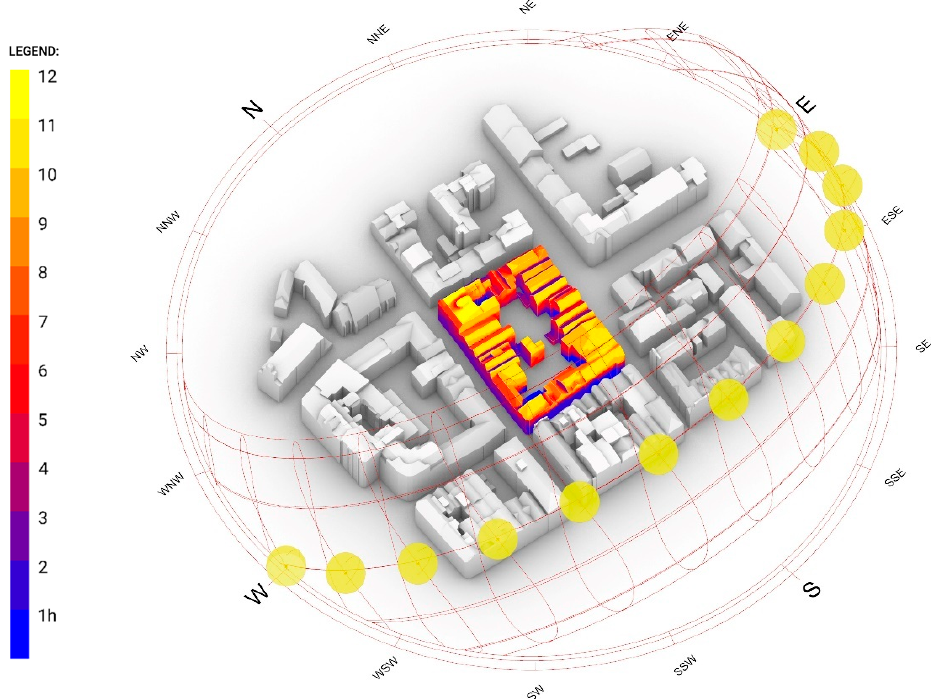
Figure 9. Analysis of insolation of roofs in the building block.